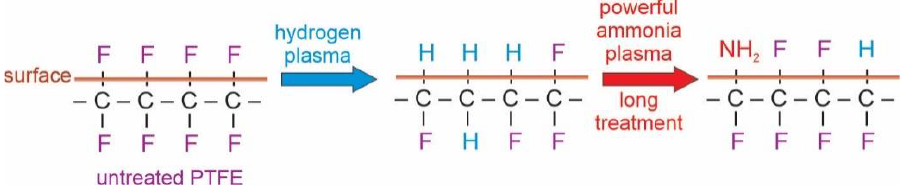
Figure 13. Simplified illustration of the effect of ammonia plasma sustained at the large power and long treatment times.